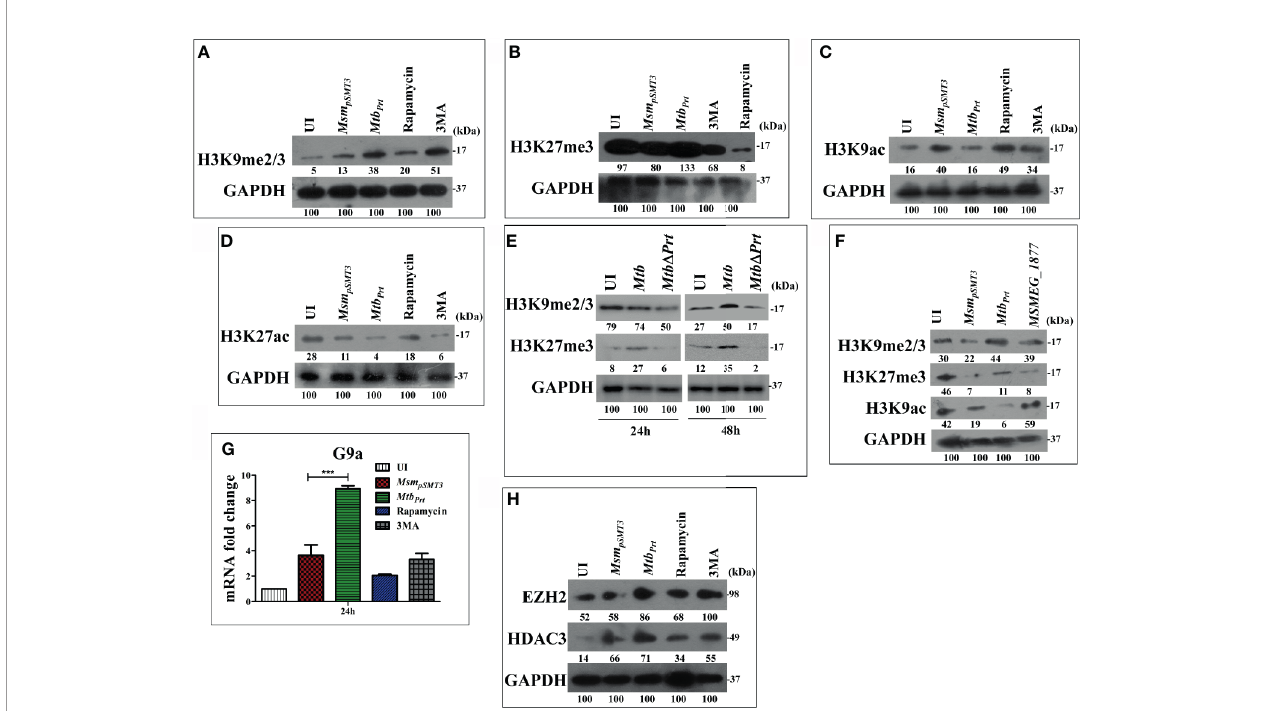
FIGURE 2 | Expression of Histone hypermethylation and acetylation in RAW macrophages infected with Msm pSMT3 , Mtb Prt , Mtb H37Rv, Mtb D Prt and MSMEG_1877. RAW264.7 cells were infected with Msm pSMT3 and Mtb Prt for 24 h. Additionally, RAW 264.7 cells were treated with rapamycin and 3MA for 2 h. The expression of (A) H3K9me2/3, (B) H3K27me3, (C) H3K9ac and (D) H3K27ac was checked at protein level by western blotting using speci fi c antibodies. (E) The level of H3K9me2/3 and H3K27me3 was checked in Mtb H37Rv and Mtb D Prt infected RAW264.7 cells by western blotting after 24 and 48 h of infection. (F) The expression of H3K9me2/3, H3K27me3 and H3K9ac in RAW264.7 infected with Msm pSMT3 , Mtb Prt and MSMEG_1877 was checked by western blotting. (G) The expression of G9a was checked at transcription level by qRT-PCR in macrophages infected with Msm pSMT3 and Mtb Prt for 24 h. (H) The level of EZH2 and HDAC3 was checked by western blotting in macrophages infected with Msm pSMT3 and Mtb Prt for 24 h. For qRT-PCR, GAPDH was taken as an internal control. The experiments were performed in triplicate (n=3). Results are shown as mean ± S.D. (error bars); ***p ≤ 0.001. Msm pSMT3- Msm harbouring pSMT3 plasmid; Mtb Prt - recombinant Msm expressing Mtb Prt (Rv3242c) ; Mtb D Prt – Mtb Prt deletion mutant in Mtb